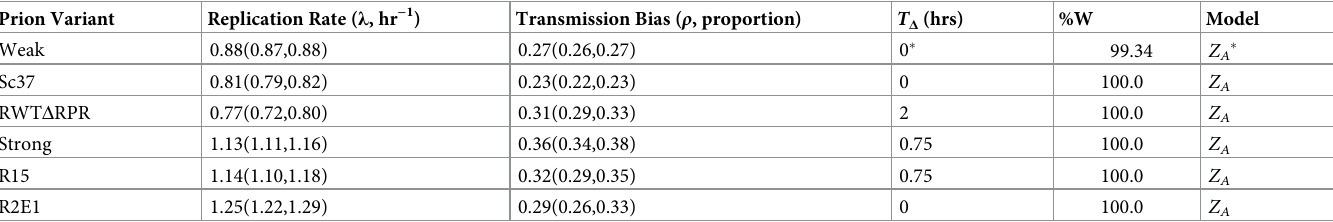
Table 2. Parameter estimates and credible intervals (95%) for six prion variants. The column labeled T Δ indicates the point of time into the experiment that best describes the beginning of the exponential phase of propagon replication. The column labeled %W presents the percent model weight for Z A , the model for asymmetric division of propagons. The asterisk ( � ) indicates the dataset not filtered for outliers (raw data) was selected using AIC c